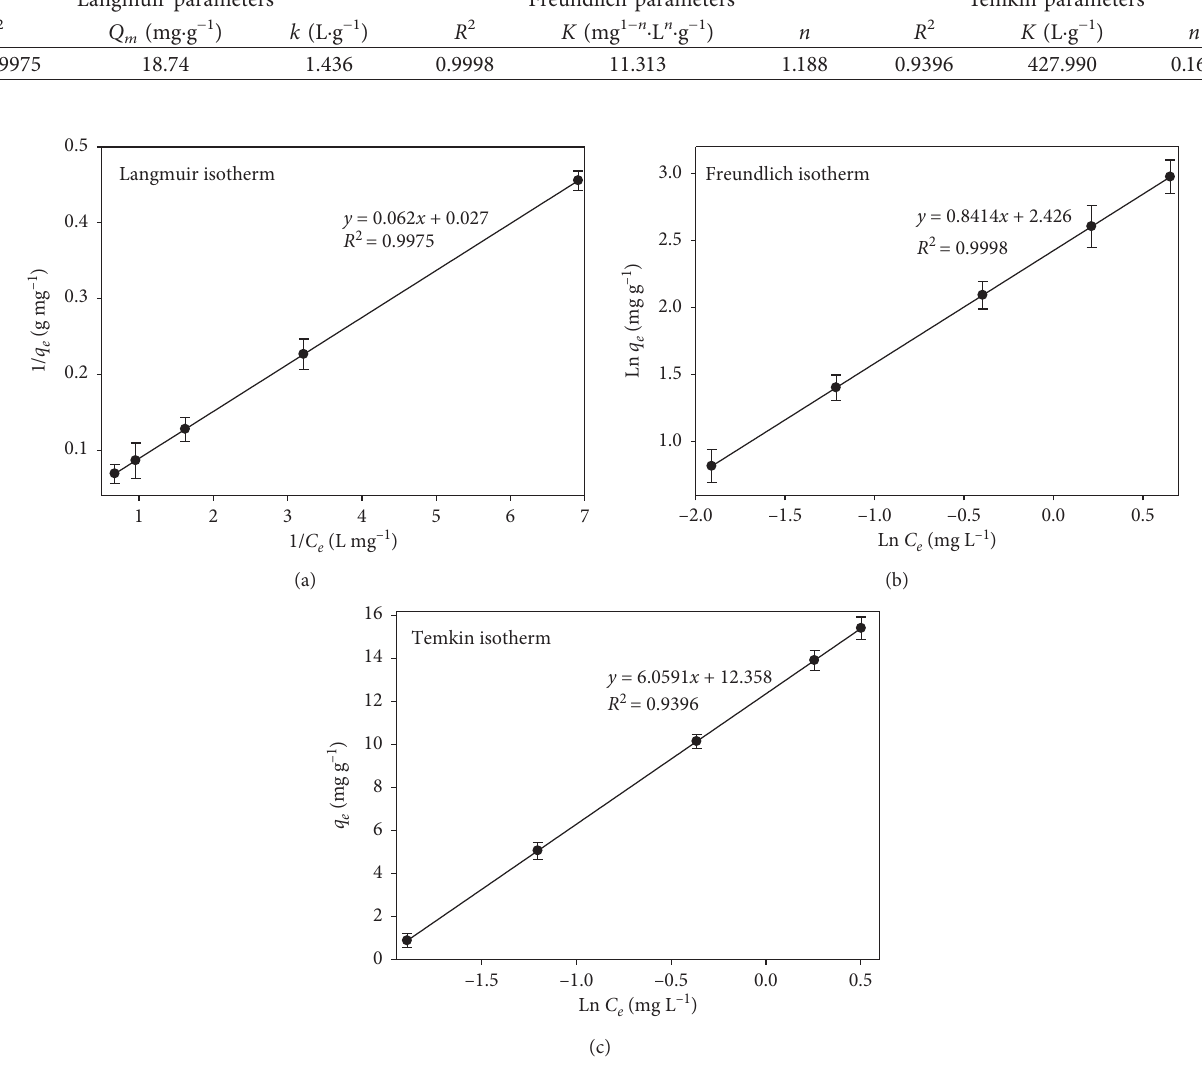
Figure 6: The adsorption isotherm plots of acid red 73 adsorbed on rice wine